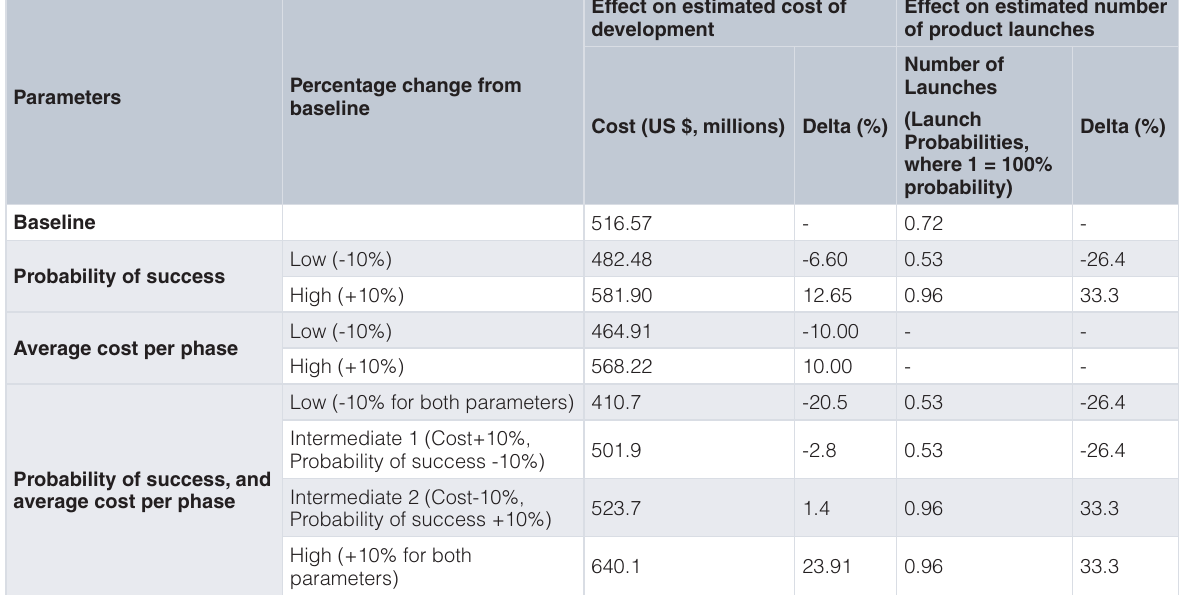
Table 9. Results of the sensitivity analysis for second run of